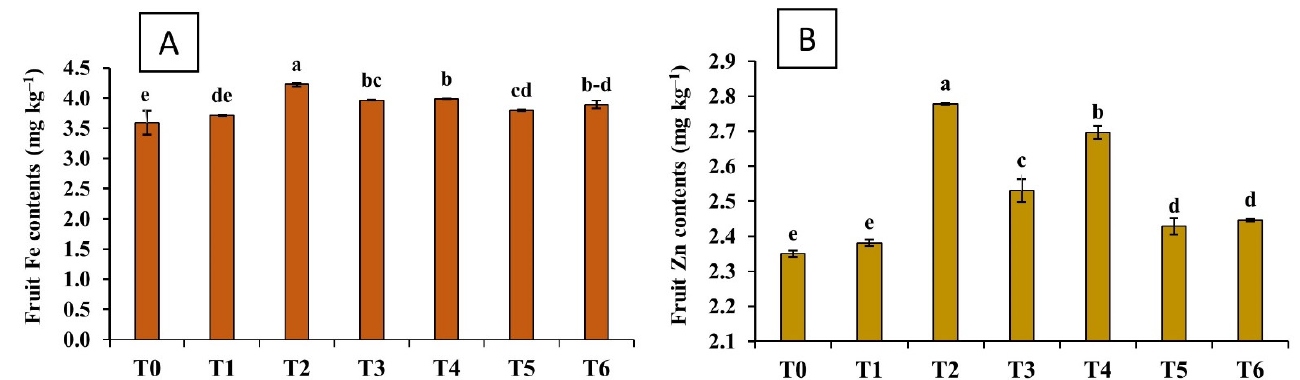
Figure 2. Effect of different carrier materials on the iron ( A ) and zinc ( B ) concentration in okra fruit under field trial. The bars represent the mean values with error bars representing the standard error of means where n = 3. The bars with different letters are statistically different from each other at p ≤ 0.05 according to the least significant difference (LSD)